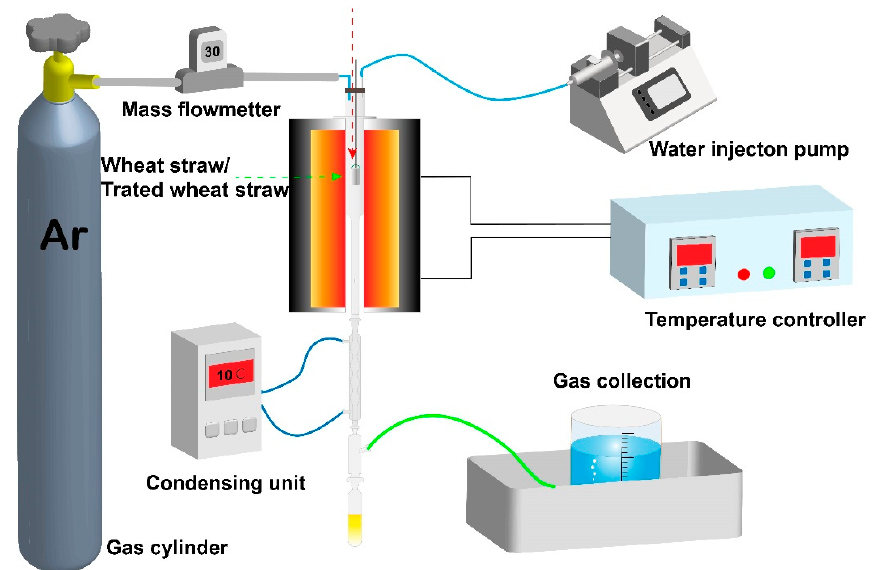
Figure 2. Schematic diagram of steam gasification of raw WS and torrefied/carbonized WS.